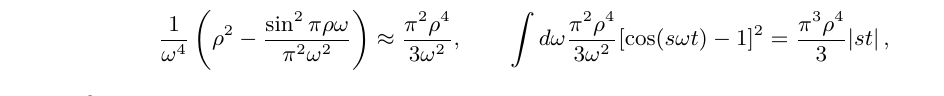
Figure 5 . We show h ‘ i and the band h ‘ i ± σ ‘ , which at long times goes as e S 0 ± graph above on a log-log plot. We put β = 15 and S 0 = 10 on this plot. The opening time of the band in ˆ t = e − S 0 t can be made arbitrarily late by increasing S 0